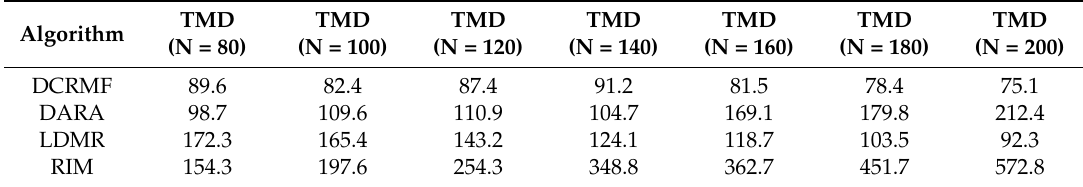
Table 3. Comparison of different methods on the change of total moving distance with the total number of nodes varying.